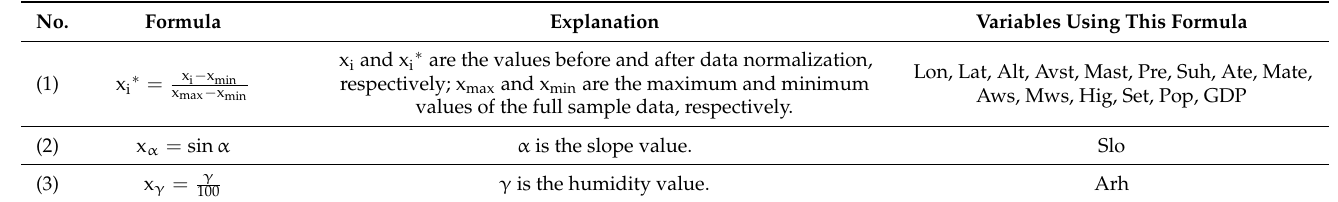
Table 3. Normalized formulas and